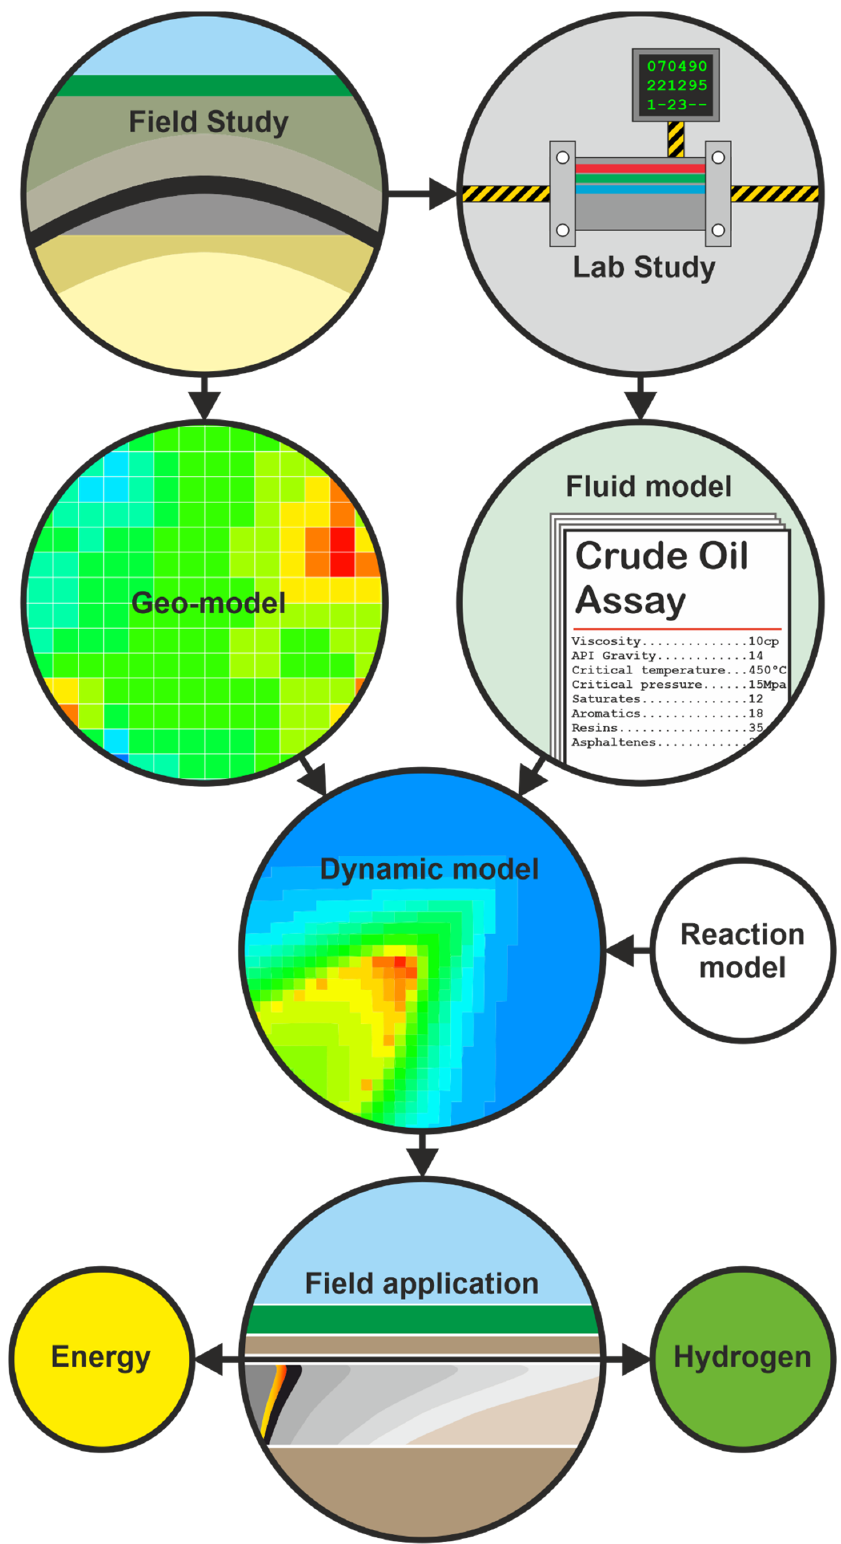
Figure 13. Complete workflow of an ISC project from start to finish based on best practices and economically successful projects from the literature.